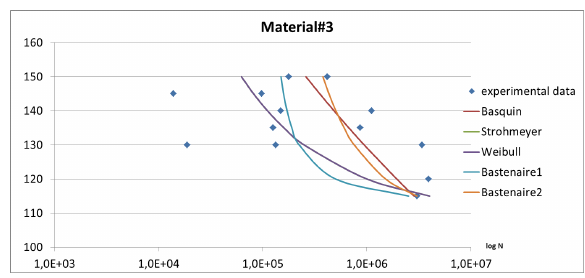
Figure 4. Applied fatigue models for Material#3.